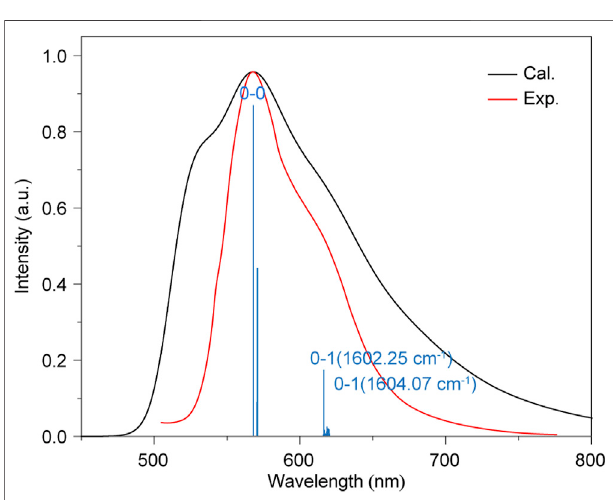
Frontiers in Chemistry |